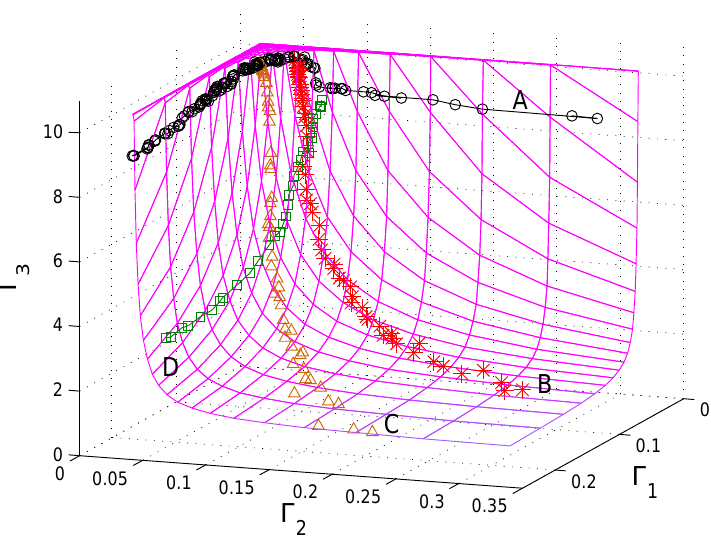
Figure 8. Fitted surface (meshed lines) and some experimental data points forming lines A, B, C and D (see text for